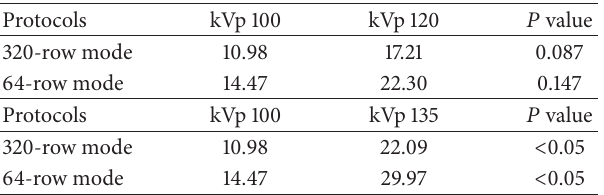
Table 2: The effect of tube voltage on ARD (mGy) for prospective EKG gated/step & shoot method at both 64-row and 320-row protocols.